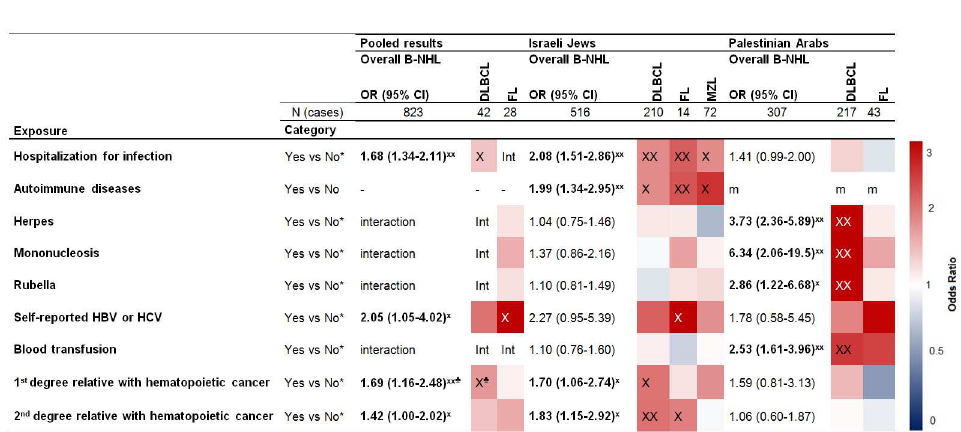
Fig 2. Self-reported medical and family history- Adjusted OR for B-NHL and subtypes, overall and by population □ . Lists the overallodds ratio (OR) with 95% confidenceinterval (CI) for all risk factors affecting overall B-cell non-Hodgkin lymphoma(B-NHL) and subtypes: diffuse large B-cell lymphoma(DLBCL), follicular lymphoma(FL) and marginal zone lymphoma(MZL), stratified by population(Jews, Arabs), frequency matched by sex and age categories (4 year groupings);adjustedfor marital status, education(yrs), ethnic origin for Jews (Ashkenazi, North African, West Asian and Sephardic)and residential region for Arabs (North, South, Center, other). The columns list the exposurecategory and the OR. The colored grid indicatesthe OR associatedwith the exposurefor each subtype separately. Red (blue) represents the exposureincreases(decreases) risk. X indicatesan associationwith P < 0.05, whereas XX indicatesP < 0.01. m indicates missing due to lack of data. Int indicatesinteractionbetweenexposureand sub-population P < 0.05. No * category includesdon’t know. □ based on schema designed by Morton et al. ♣ Reported by Kleinsternet